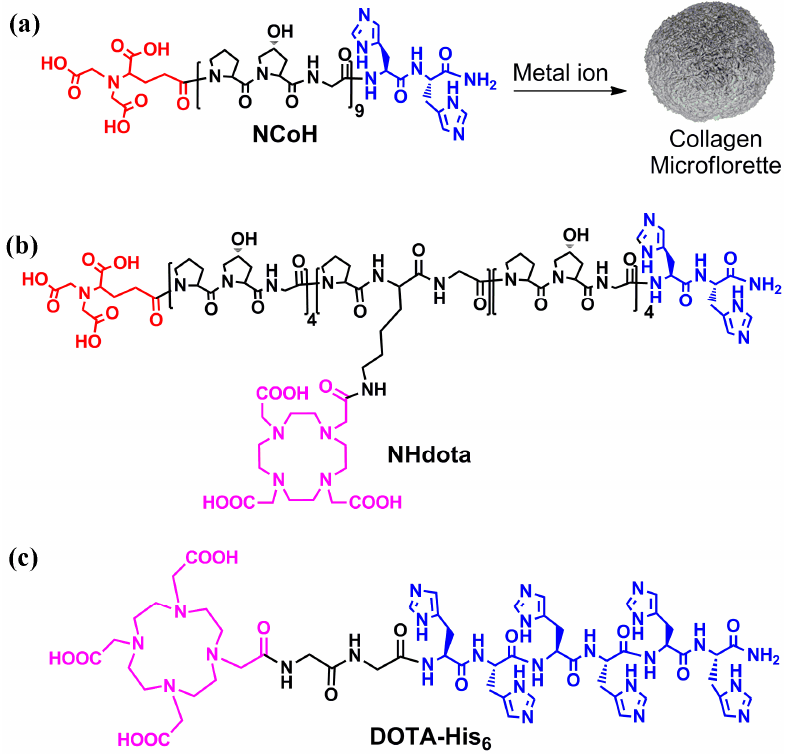
Figure 1. Structures of metal-triggered self-assembling peptides ( a ) NCoH , ( b ) NHdota and ( c ) DOTA-His 6 , with the nitrilotriacetic acid in red, histidines in blue and DOTA in pink. ( a ) Metal-promoted assembly of NCoH into microflorettes is shown.